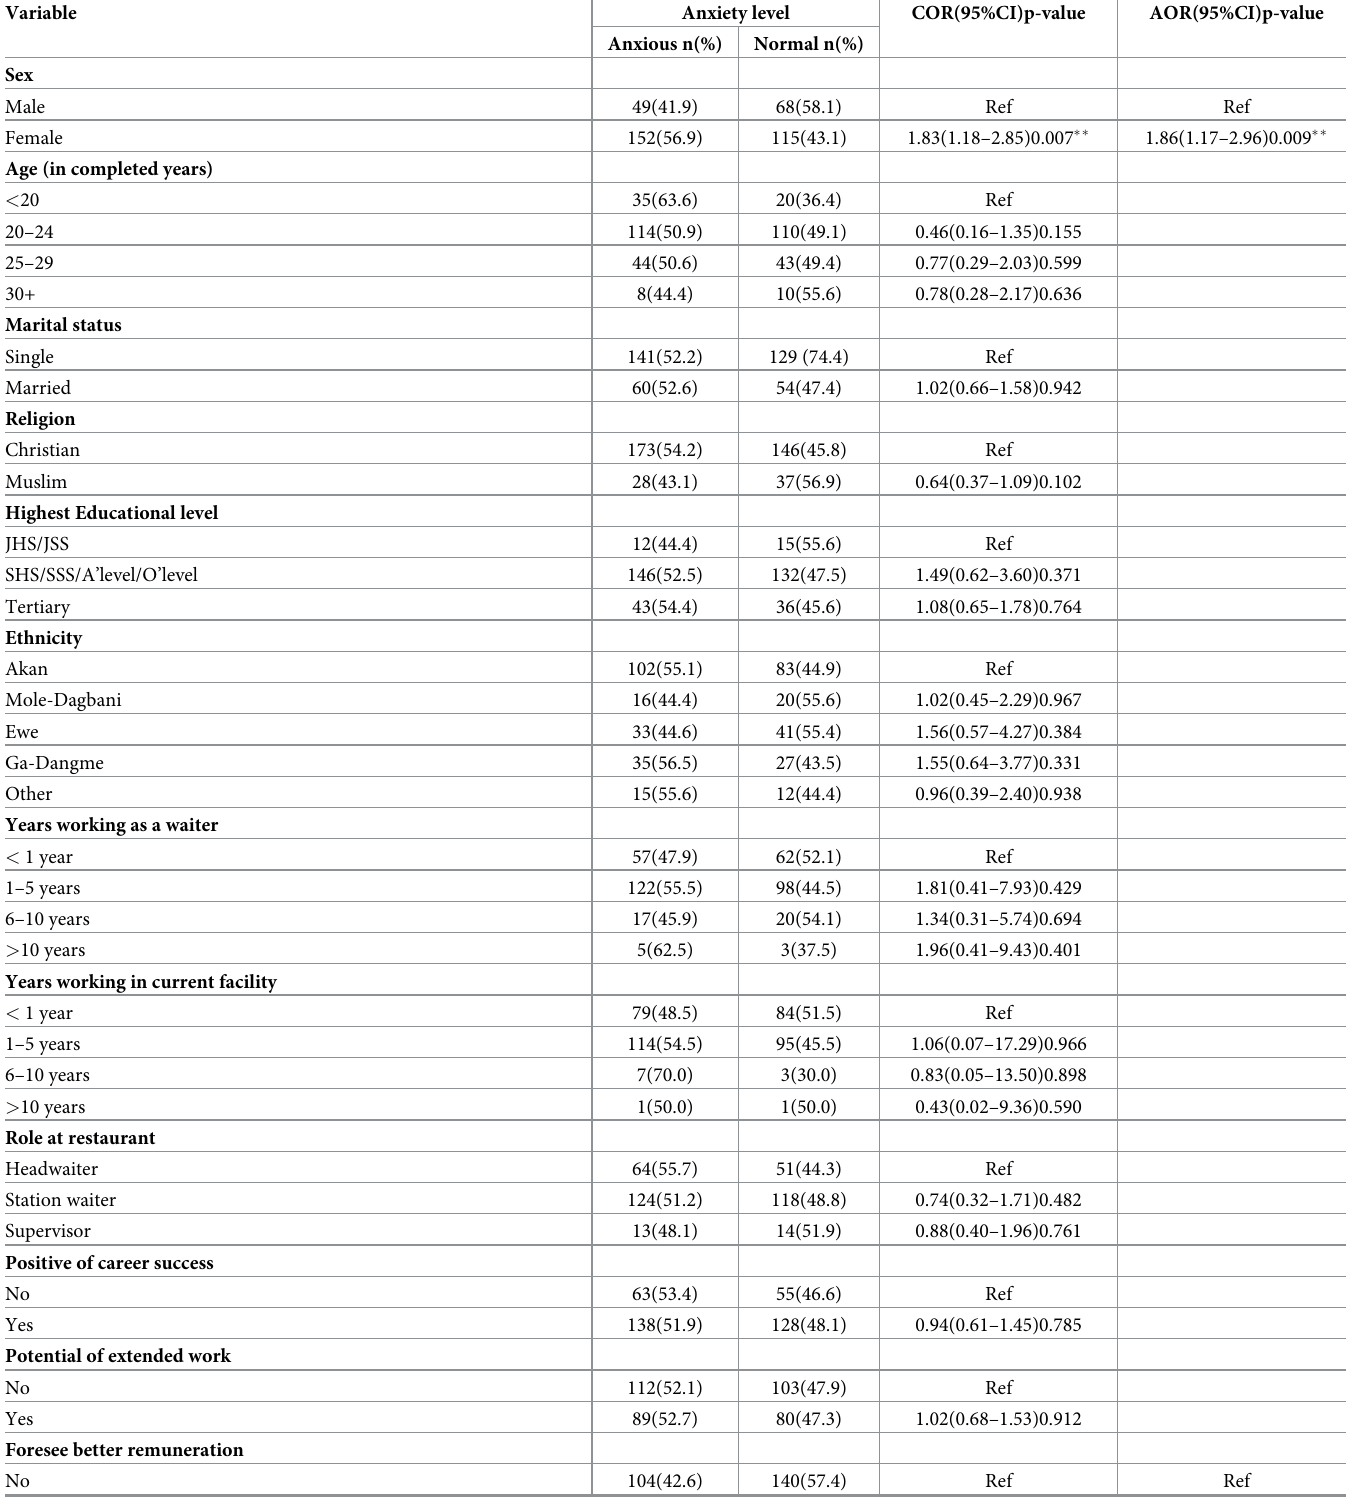
Table 5. Predictors of anxiety among